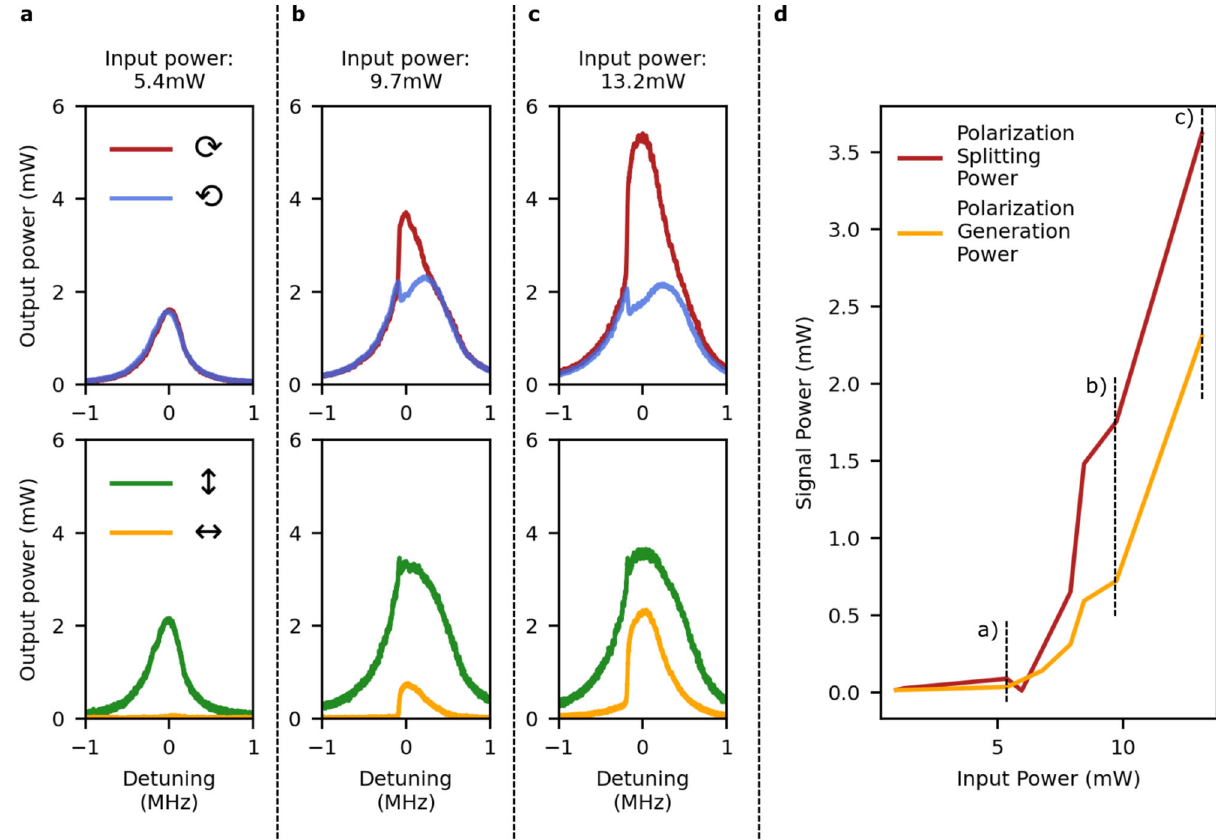
Fig. 3 Measurement of spontaneous polarization symmetry breaking. a At low powers, both the right- (red) and left-handed (blue) polarization states couple equally into the cavity. This corresponds to the output light always having vertical polarization (green), with no horizontal (yellow) component. b Above threshold, spontaneous symmetry breaking changes the relative optical power in the different polarization modes in a range of cavity detunings. In this regime, there has been the spontaneous generation of horizontally polarized light, and a reduced amount of the vertical polarization. c The symmetry breaking increases at higher input powers. d Threshold behavior for the polarization symmetry breaking. The red curve shows the maximum power difference between left- and right-circular light for different input powers. The yellow curve shows the power of the generated horizontally polarized light.